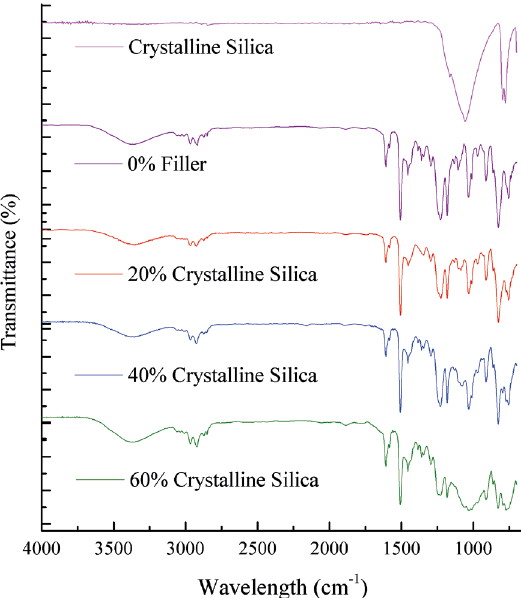
Figure 3. FTIR spectrum for the mixtures prepared with 20, 40, and 60% (wt) crystalline silica